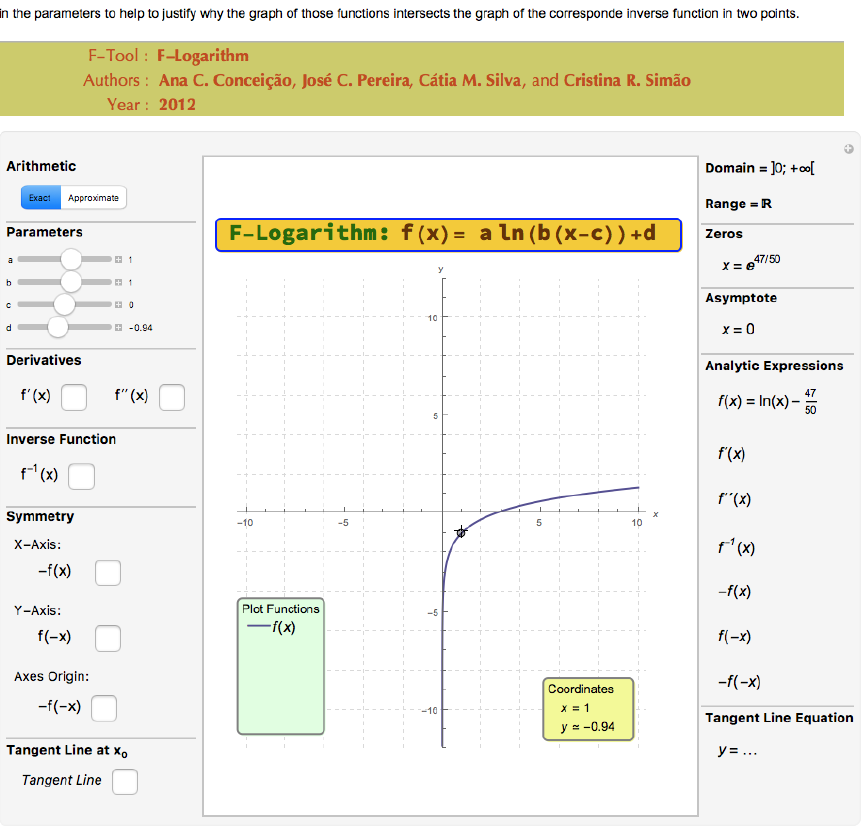
Figure 15. Image that illustrate a challenging problem that can be solved as autonomous stu- dents’